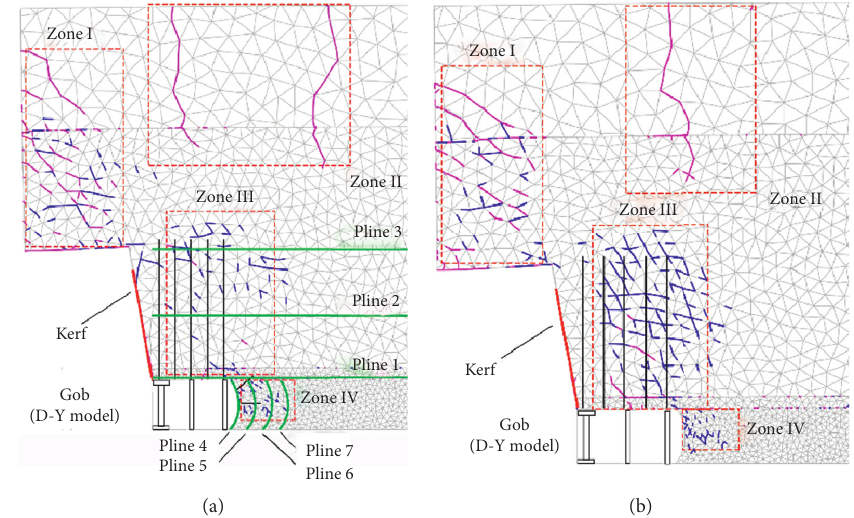
Figure 9: Crack propagation network in the surrounding rock: (a) normal retaining roadway; (b) abnormal retaining roadway.